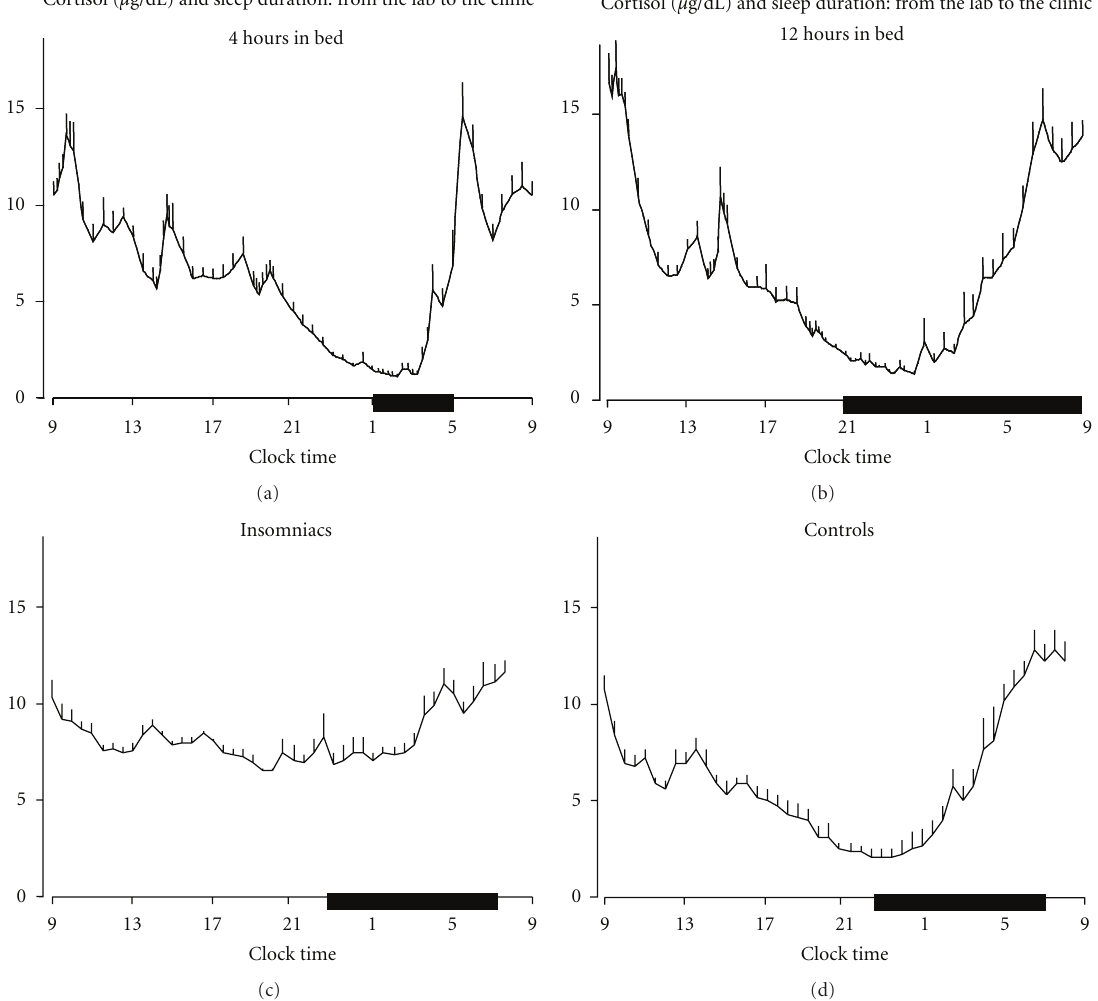
Figure 6: Cortisol rhythm under di ff erent sleep conditions. (a) and (b): 24-hour (+ SEM) cortisol profiles under 4 hours (a) and 12 hours (b) bedtimes (Adapted from Spiegel et al. [84]). (c) and (d): 24-hour (+ SEM) cortisol profiles in young insomniacs (c) and age, and BMI- matched controls (d) (Adapted from Vgontzas et al. [105]). Black bars represent the sleep